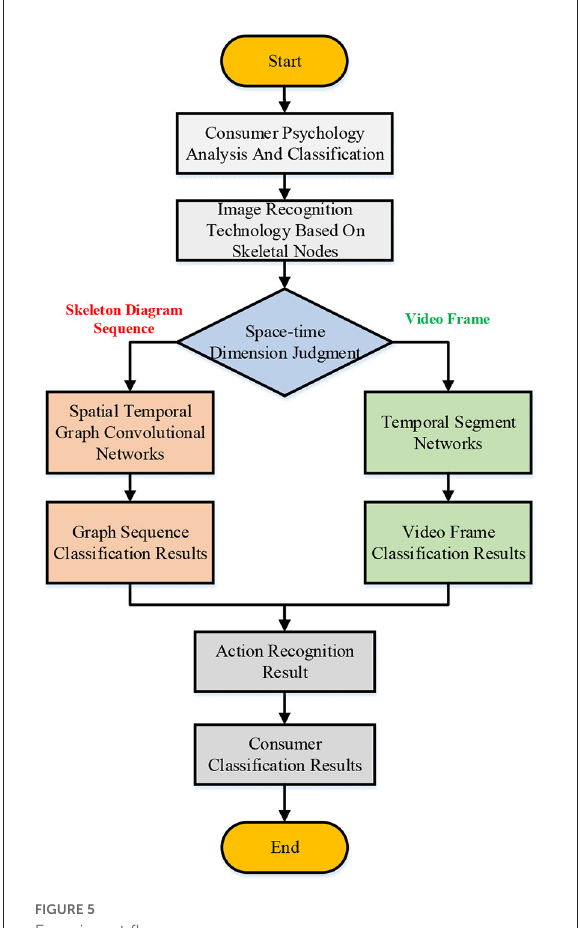
FIGURE5 Experiment